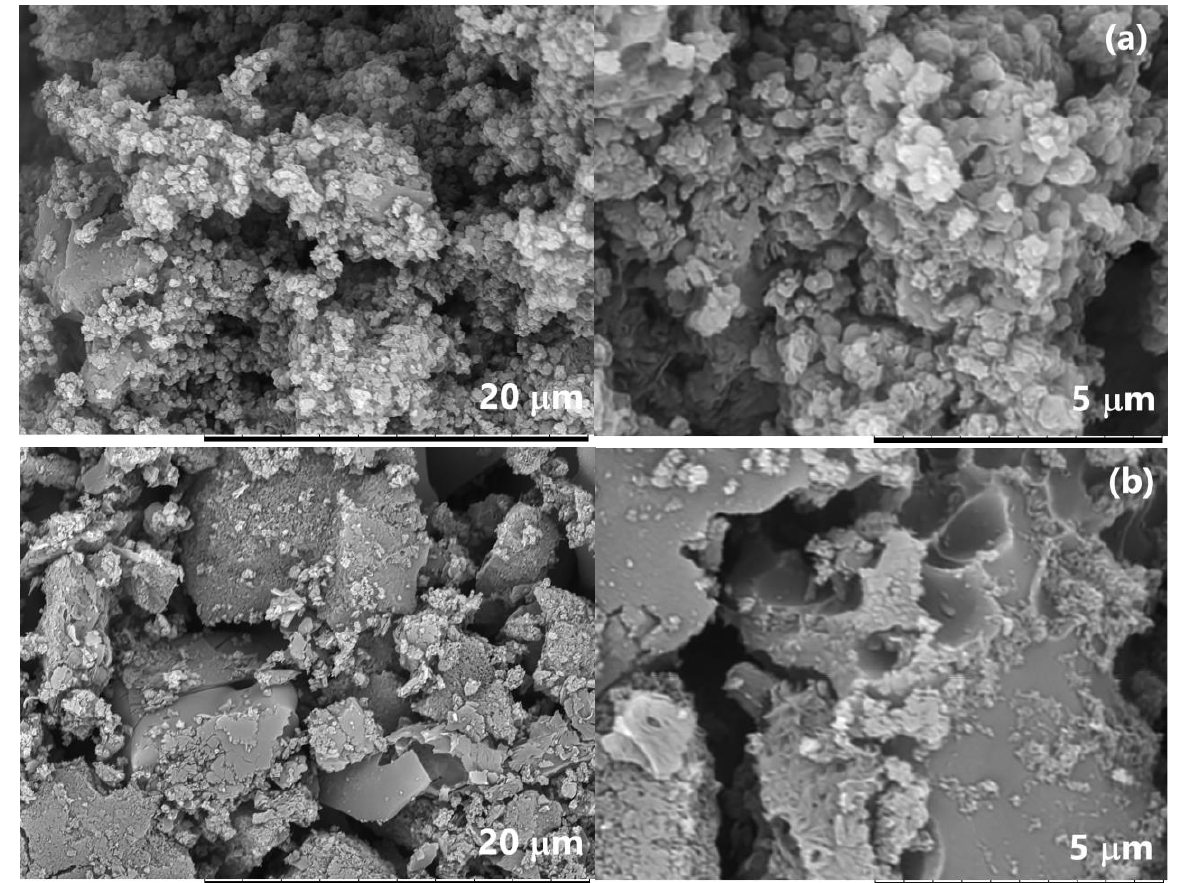
Figure 10. SEM images of IR-PAN-a/PDPAC ac ( a ) and IR-PAN-a/PDPAC alk ( b ).